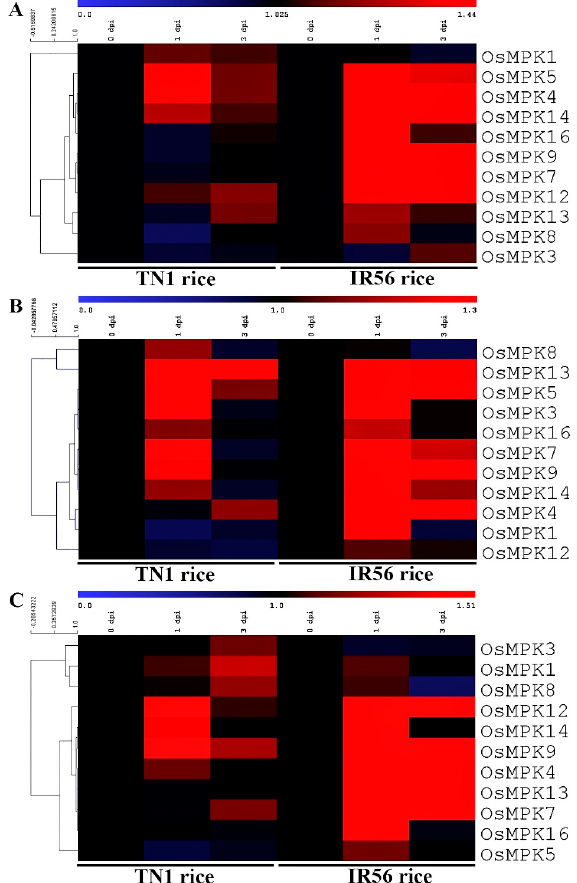
Figure 7. An expression analysis of the BPH-induced OsMPKs under exogenous treatment with different phytohormones in the IR56 and TN1 rice varieties. ( A ) Treatment of SA, ( B ) treatment of methyl jasmonate (MeJA), and ( C ) treatment of ethephon (ET). The analysis was performed based on the qPCR data of the 11 BPH-induced OsMPK s using the MEV program. The red color represents a positive correlation between the OsMPK expression and phytohormone treatment, and the blue color indicates a negative correlation between OsMPK expression and phytohormone treatment. The hierarchical clustering has been constructed based on the Pearson Correlation metric, and the gene order has been optimized.